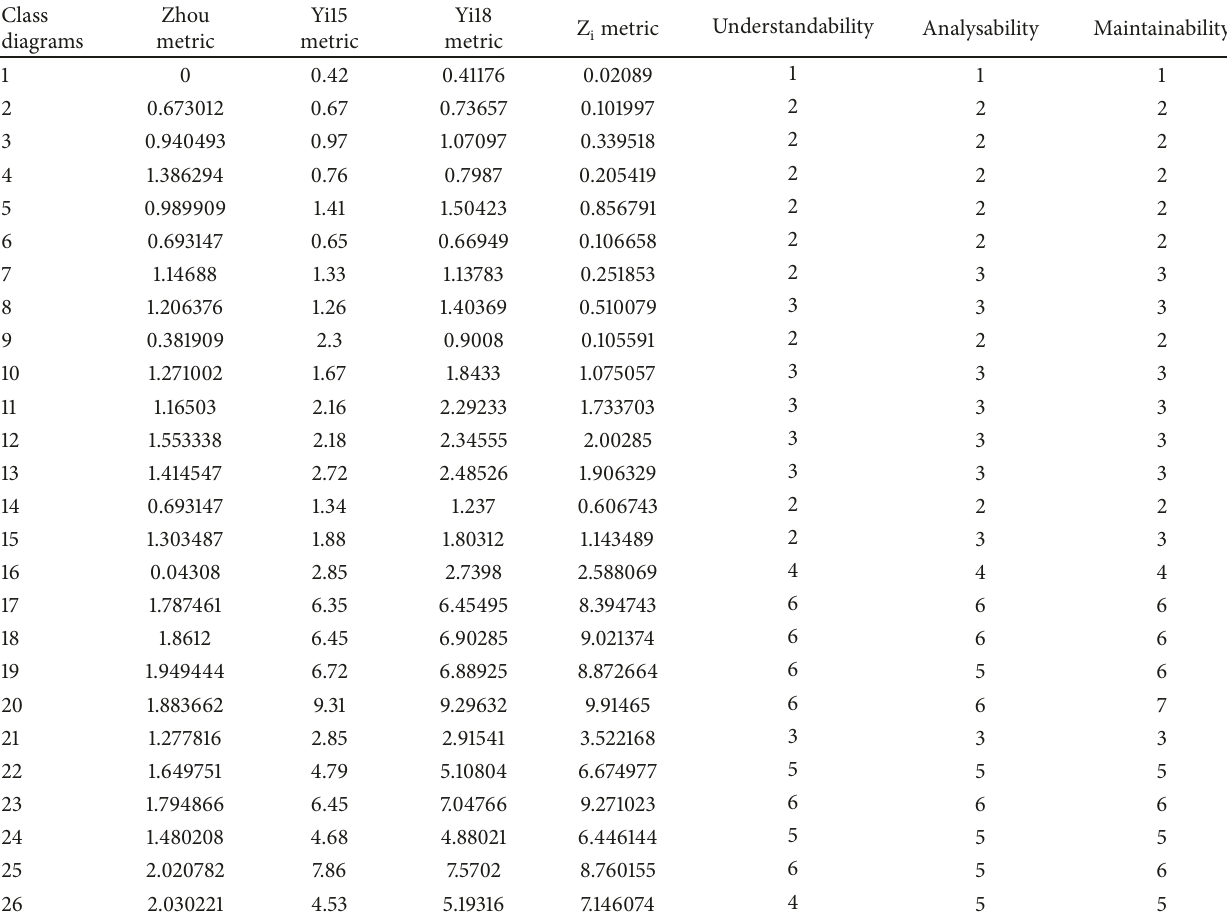
Table 2: Comparing the experiment results of measurement